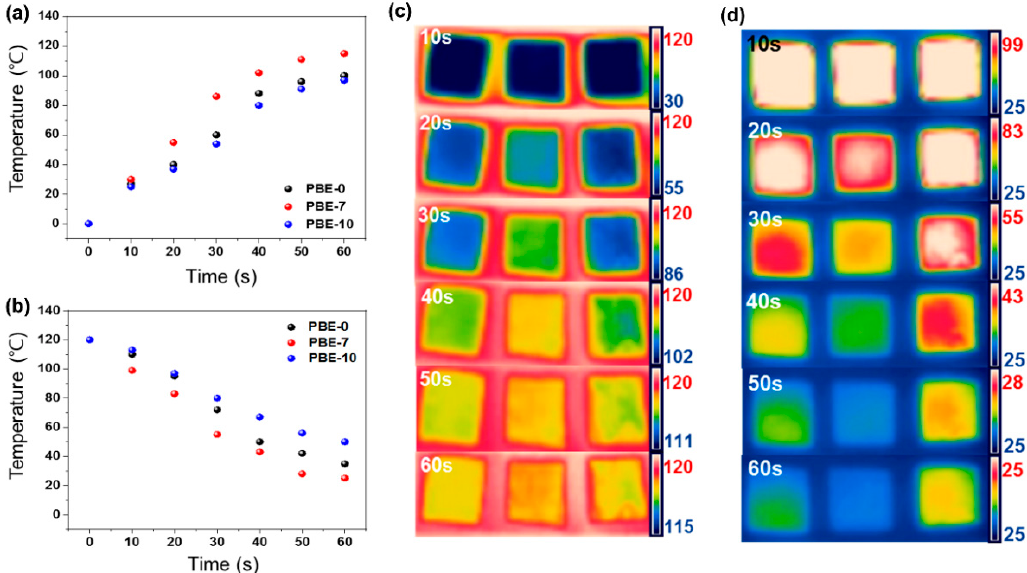
Figure 7. Infrared thermal camera of the BNNS/epoxy nanocomposites: ( a ) temperature change curve of heat absorption over time, ( b ) temperature change curve of heat dissipation over time, ( c ) optical images of the heat absorption over time, and ( d ) optical images of the heat dissipation time.